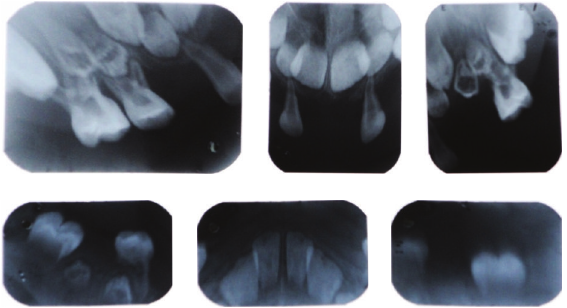
Figure 18: Intraoral periapical